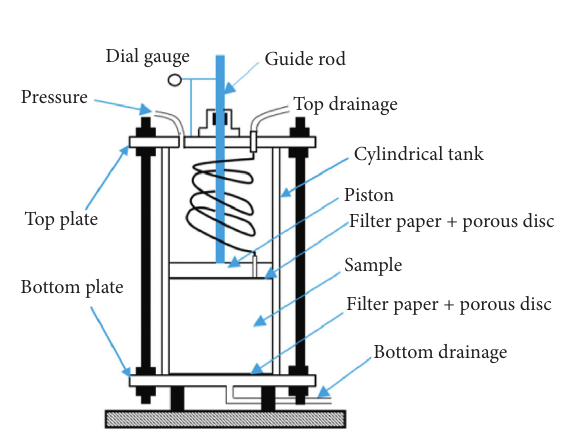
Figure 1: Consolidation tank for sample